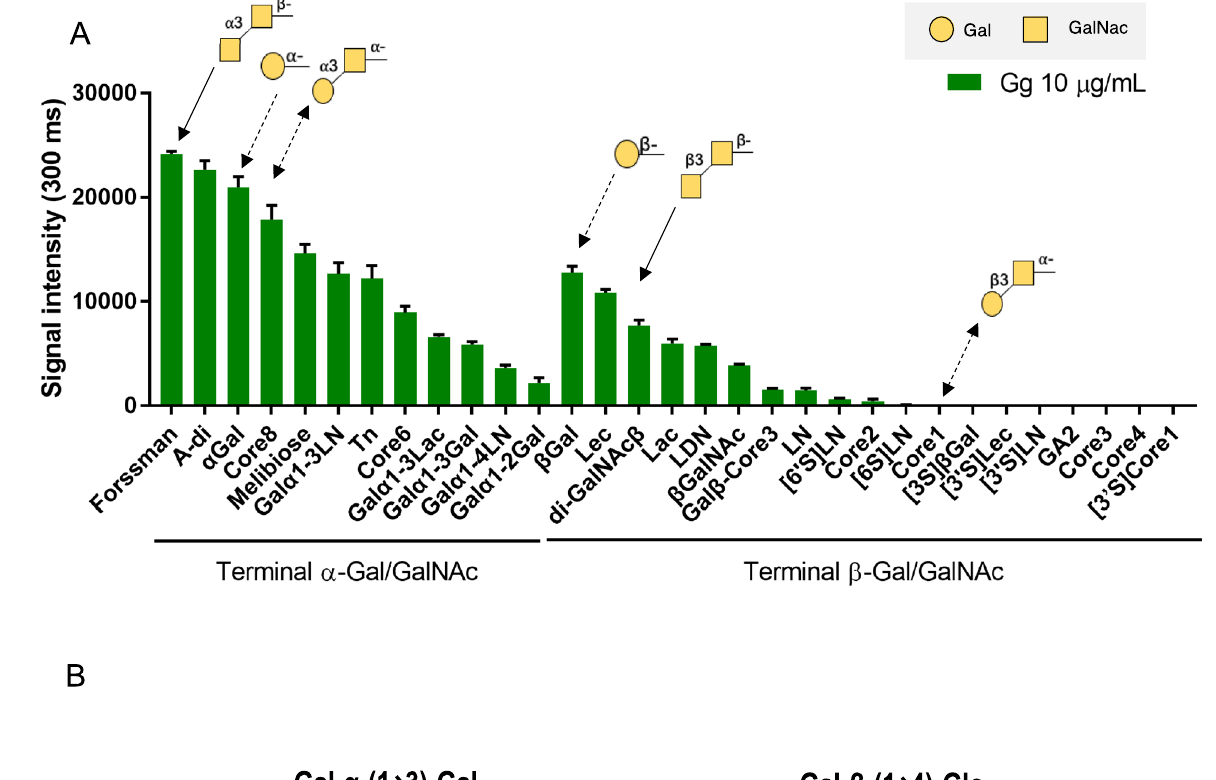
Figure 3. Analysis of Gg specificity. ( A ) Signal intensities of Cy3-labeled Gg to galactose terminal glycans. Glycans with similar structures which only differ in Gal/GalNAc linkage are represented using similar arrows. Cartoon representations of glycan structures are shown on top of each corresponding arrow. ( B ) HA1-D270F model bound to Gal-α-1,3-Gal and Gal-β-1,4-Glc